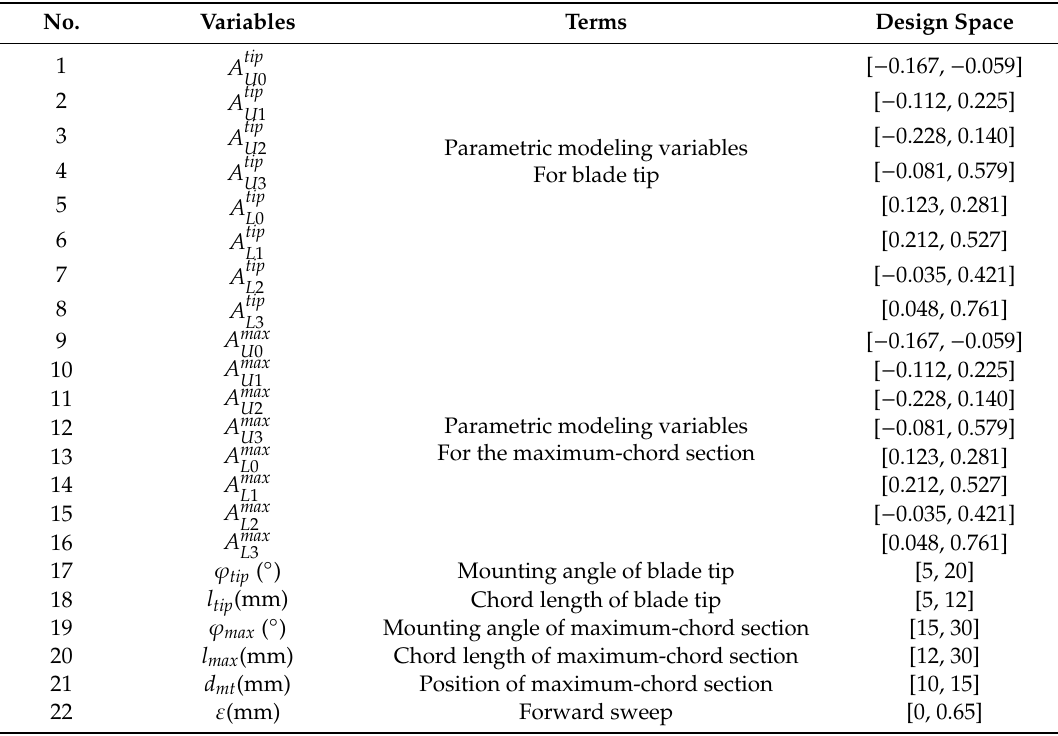
Table 10. Variables of rotor blade.